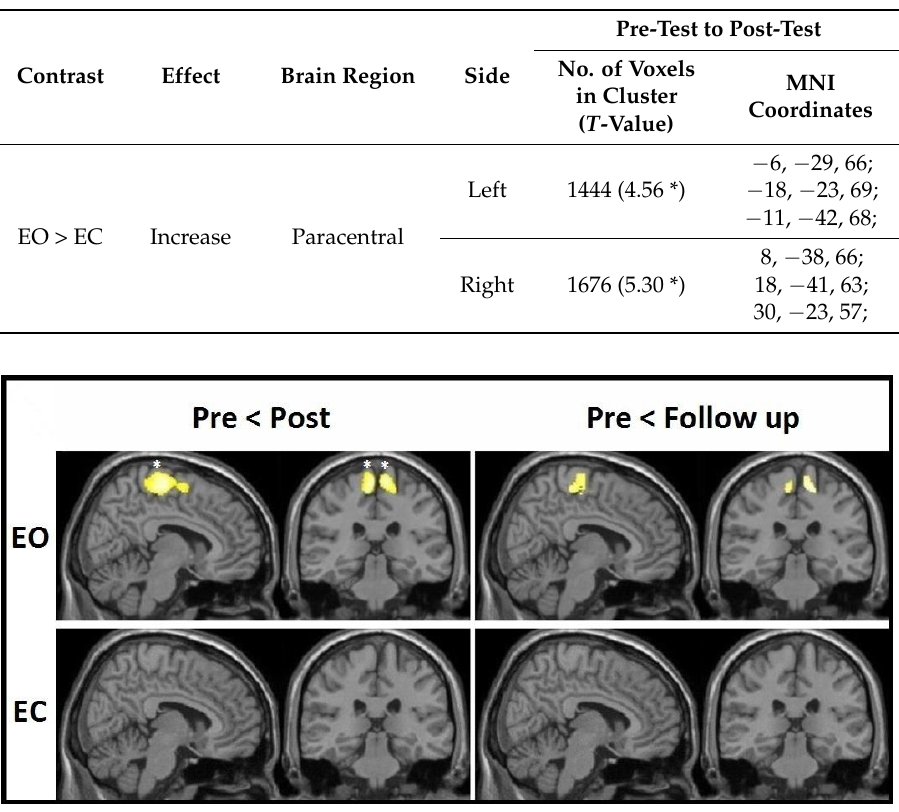
Figure 3. VBM-observed GM increments—within-group effects from pre-test to post-test and from pre-test to follow-up for both EO and EC groups; * FWE-corrected.